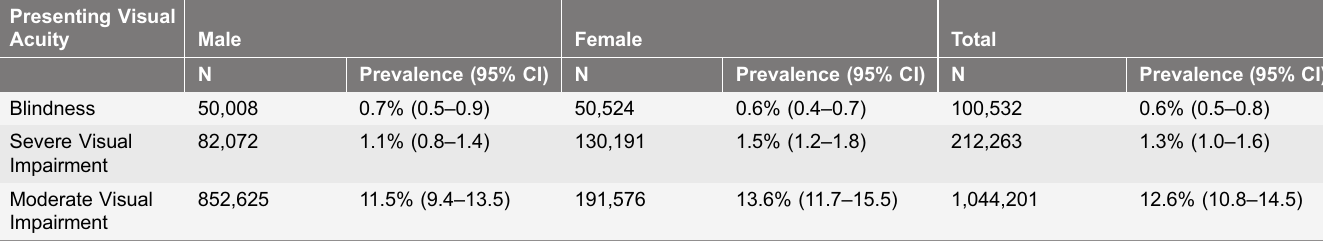
Using direct standardization, regional analysis of the age and sex adjusted prevalence of blindness, SVI, and MVI in Thailand is shown in Table 4. Each region demonstrated similar adjusted prevalence except the Bangkok area, which appeared to have lower prevalence of blindness. Cataract remained the most common cause of overall blindness and avoidable blindness and VI (Tables 5,6). Cataract was responsible for 69.7% of blindness. Refractive errors including uncorrected aphakia were responsible for 6.0% of blindness while complications after cataract surgery were responsible for 1% of all blindness. Diabetic retinopathy was responsible for 5.1% of blindness while glaucoma and corneal opacities were responsible for 4.0% and 2.0% of blindness respectively. Uncorrected refractive errors were responsible for almost a third (26.7%) of MVI and were the second most common cause after cataract (60.0%) among those with MVI. Among the blind, 92.1% lost their vision from avoidable causes, while among VI, 97.9% was due to avoidable visual impairment (Table 6). Table 7 displayed the cataract surgical coverage (the percentage of people in the survey who had cataract surgery compared to the number who required it). The cataract surgical coverage (CSC) for blind persons was 95.1% (91.7% for males and 96.5% for females), for SVI persons it was 85.3% (81.6% males, 87.2% females) and for those with MVI it was 46.6% (42.6% males, 48.8% females). The overall CSC for blind eyes was high (79.6%). Despite relatively high cataract surgical coverage, the backlog for blinding cataract (people waiting who might benefit from surgery) was calculated (69.7% of 100,532) to be 70,071 persons. If Table 3. Distribution of visual acuity with available correction in the better eye. Presenting Visual